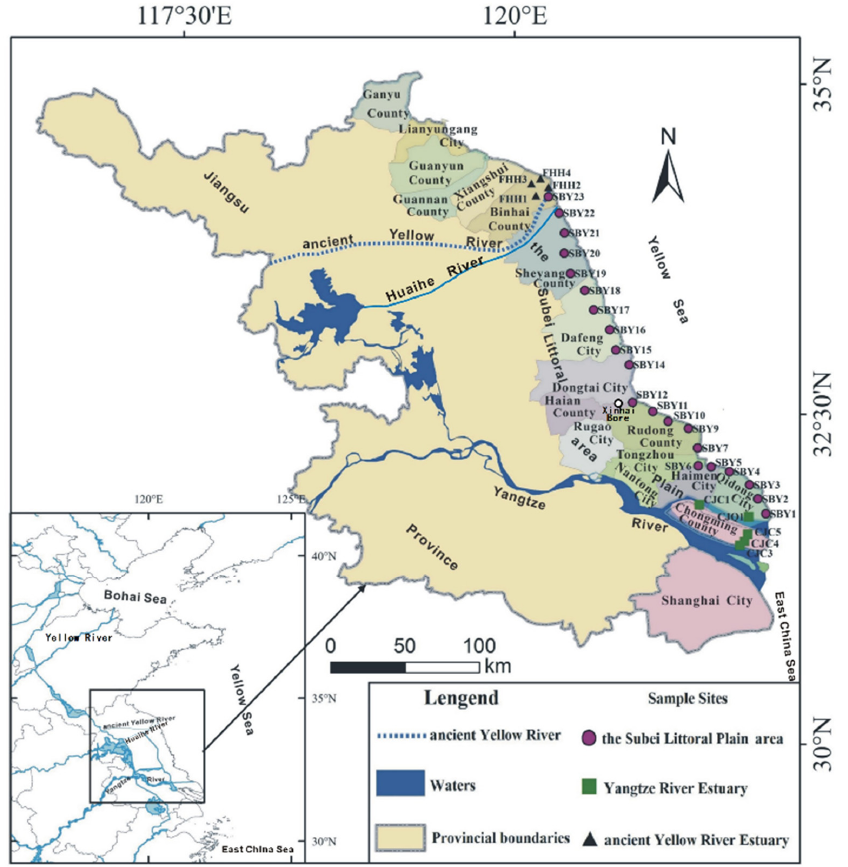
Figure 1. Study area and sampling sites. GPS point information can be found in Supplementary Materials.